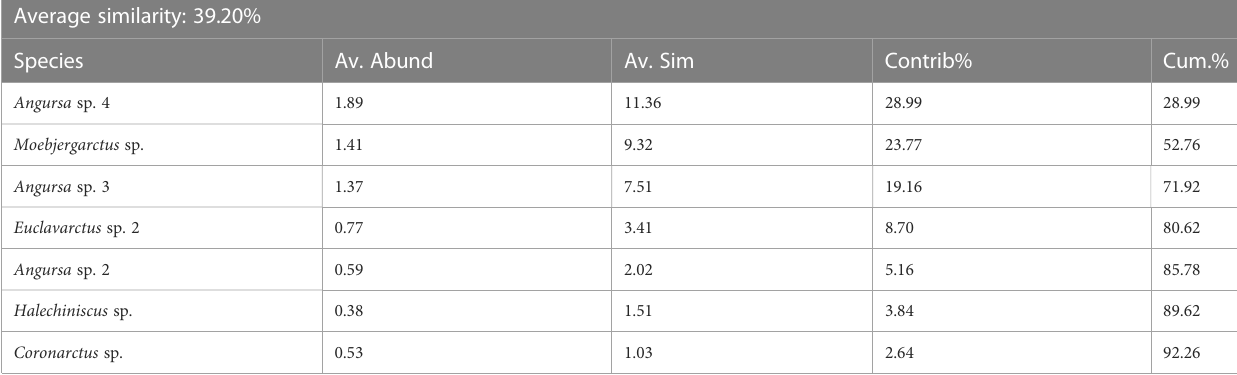
TABLE 4 SIMPER analysis for the contributions of species to the average similarity among all stations in the deep South China Sea. Average similarity: 39.20% Species